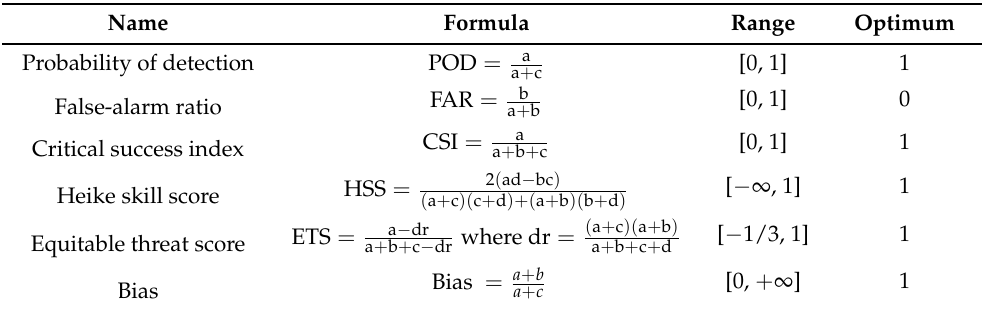
Table 3. Names, calculation formula, range, and optimum values of the various metrics for delineat- ing the rainfall area.